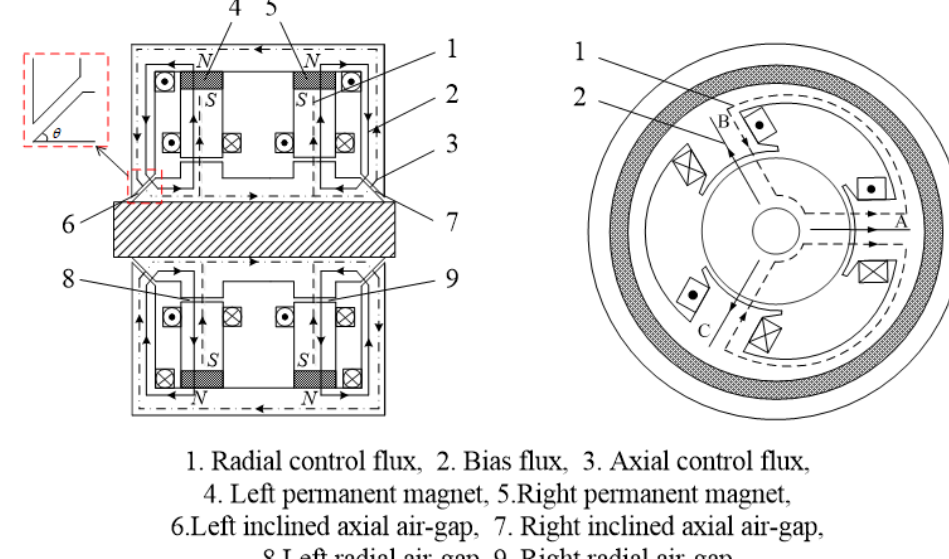
Figure 2. Flux paths of the 5-DOF AC–DC HMB.